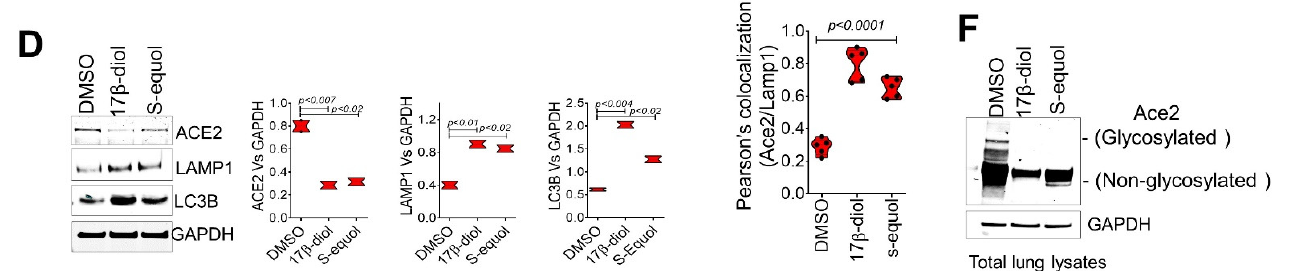
Figure 3. Estrogens bind to ACE2 glycans to promote its internalization. ( A ) Glycan–estrogen interactions stabilize ACE2 Glycan-residues at E57, N53, K341, and V339 (red color). ( B ) MEP maps show the electrostatic impact of estrogen molecules on the surface of ACE2 glycans. The energy scale ranges from − 0.075 µ a (red) to 0.075 µ a (blue). ( C ) Immunofluorescence staining of human ACE2 (magenta) and the lysosome marker LAMP1 (green), shows loss of ACE2 membrane levels in HUVECs treated with 17 β -diol or S-equol compared with the control group (DMSO). ( D ) Immunoblot shows decreased levels of total ACE2 protein which associates with increased endocytosis activity as evidenced by immunoblot for LC3b and LAMP1. ( E ) Histologic analysis of wild-type mouse lungs after 48 h of intratracheal instillation with 17 β -diol or S-equol shows loss of Ace2 signal (red) on the membrane of alveoli cells. Estrogen-treated lungs show greater Ace2-Lamp1 colocalization (white arrows) indicating internalization of the receptor. ( F ) Immunoblot shows decreased levels of total and glycosylated Ace2 proteins in estrogen-treated lungs from male mice. Quantification of protein levels of three replicate experiments is shown. Student’s T-test, 2 tails. Bar graphs are presented as mean with error bars (±SD).